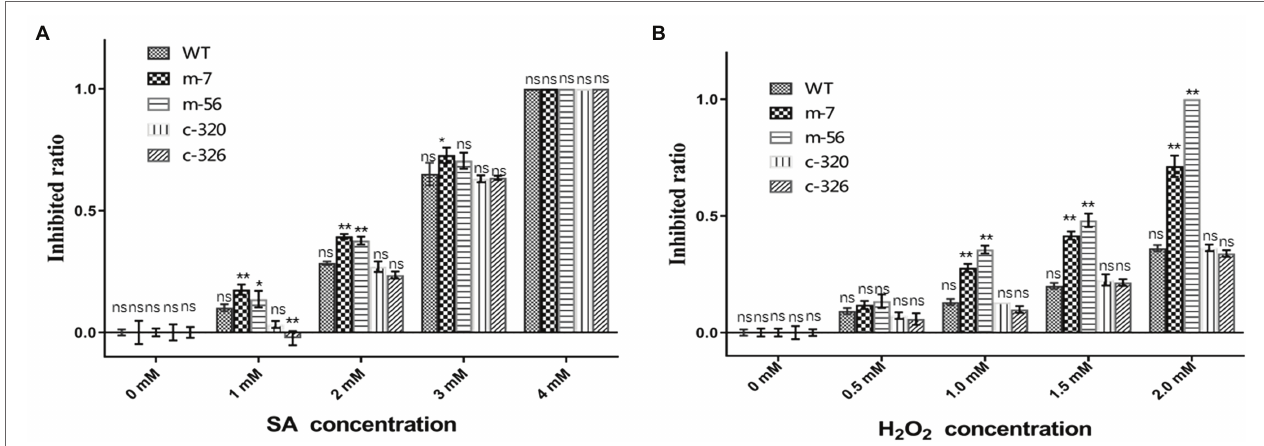
FIGURE 4 | Susceptibility of the VpxlnR mutant to host mimic stresses. (A) Effect of SA stress on strain growth. Wild-type (WT), VpxlnR deletion mutant (m-7 and m-56), and complementation (C-320 and C-326) strains were grown on PDA medium supplemented with the indicated SA concentrations and incubated at 25 ° C for 36 h. (B) Impact of oxidative stress on colony growth. Strains were cultured on PDA medium supplemented with H 2 O 2 and incubated at 25 ° C for 36 h. Each treatment was repeated three times, and colony diameters were recorded at 36 h. The data were recorded at 36 h. The statistical analysis was performed by two-